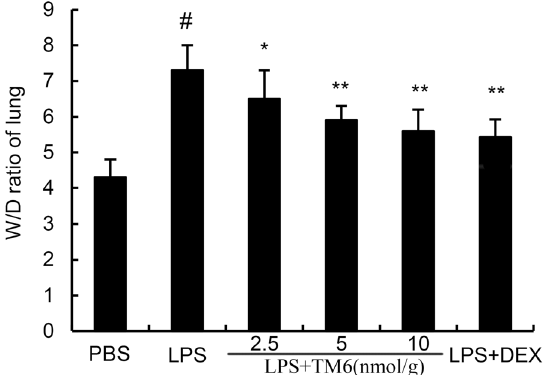
Figure 2. The effect of TM6 on lung wet/dry radio. Mice were pretreated with TM6 (2.5, 5 and 10 nmol/g) and DEX (5 mg/kg) 1 h prior to an i.n. administration of LPS. The lung wet/dry ratio was determined 7 h after LPS challenge. The values presented are the means ± SEM (n = 6). # P < 0.01 is significantly different from the control group; * P < 0.05 and ** P < 0.01 are significantly different from the LPS